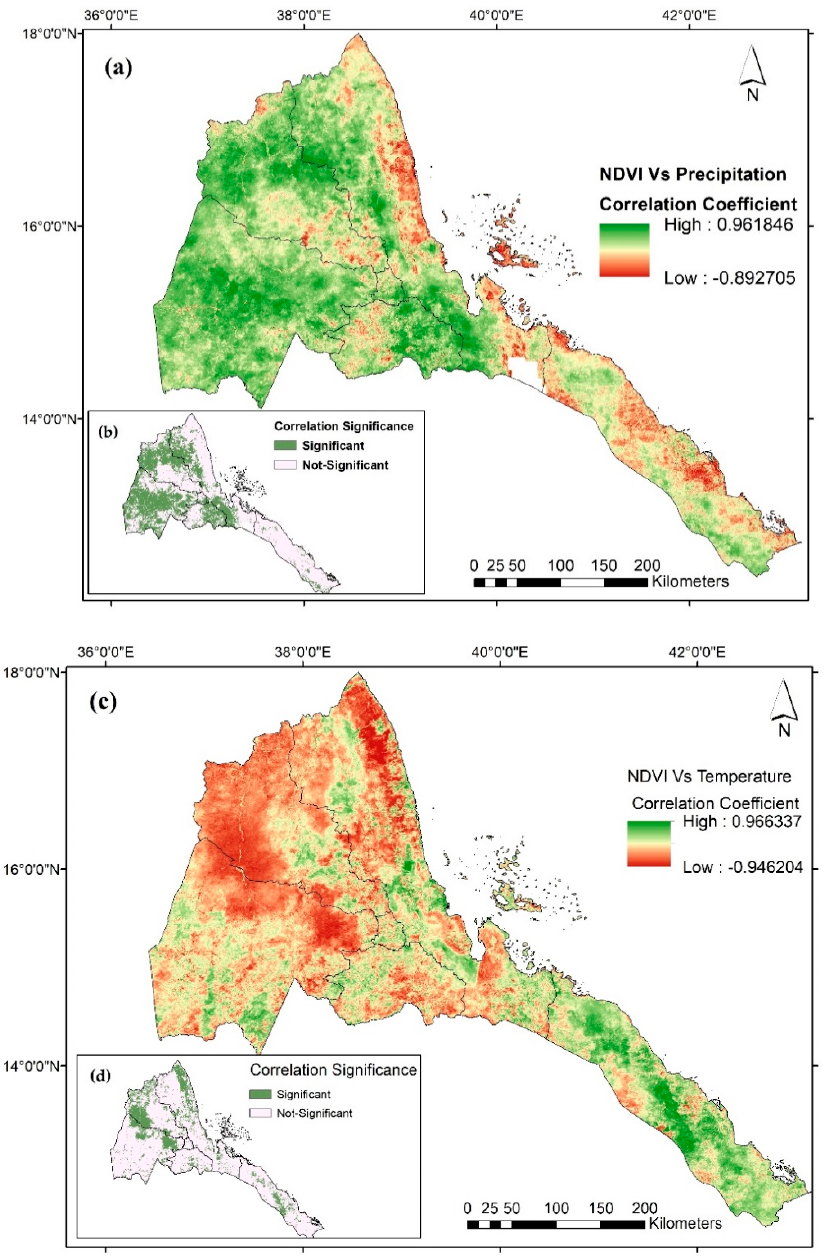
Figure 8. The correlation relationship between the growing season mean values of NDVI and the growing season total precipitation ( a ) and mean temperature ( b ) during 2000–2017, respectively; correlation significant levels are shown in ( b ) and ( d ).